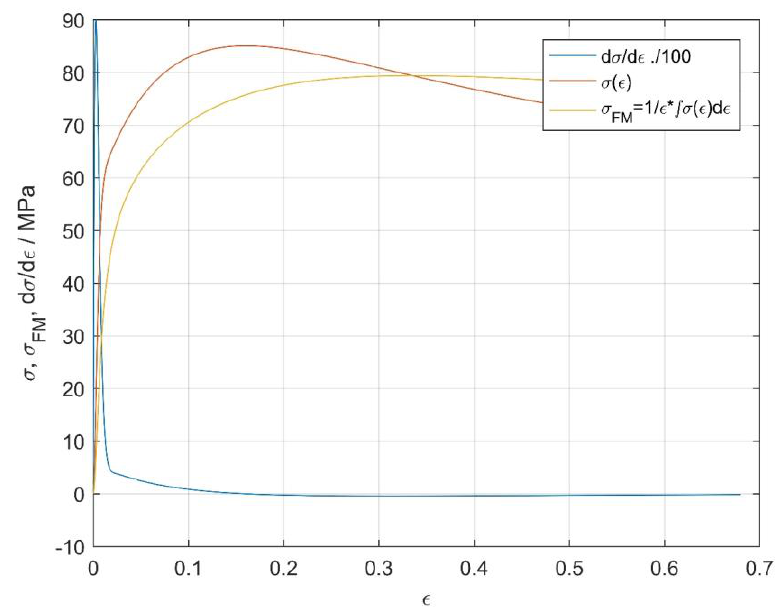
L , L − 1 ↔ ℒ,ℒ −1 Figure 3. Flow curve G (cid:48) ( s ) σ ( (cid:101) ) at (1000 ◦ C, 0.01 s − 1 ), flow stress derivative with respect to ↔ 𝜎(𝜖) at (1000 °C, 0.01 s -1 ), flow stress derivative with respect to strain Figure 3. Flow curve 𝐺′(𝑠) strain d σ / d (cid:101) ( (cid:101) ) and average flow stress σ FM ( (cid:101) ) . All three quantities are determined along whole 𝑑𝜎 𝑑𝜖⁄ (𝜖) and average flow stress 𝜎 𝐹𝑀 (𝜖) . All three quantities are determined along whole defor- mation range as continuous functions of strain 𝜖 based on G ’ (s) . deformation range as continuous functions of strain (cid:101) based on G (cid:48) ( s